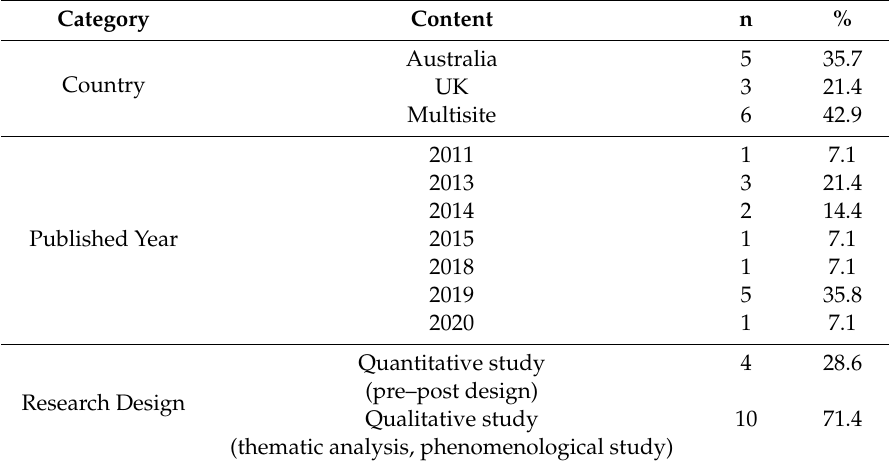
Table 1. General characteristics of the reviewed